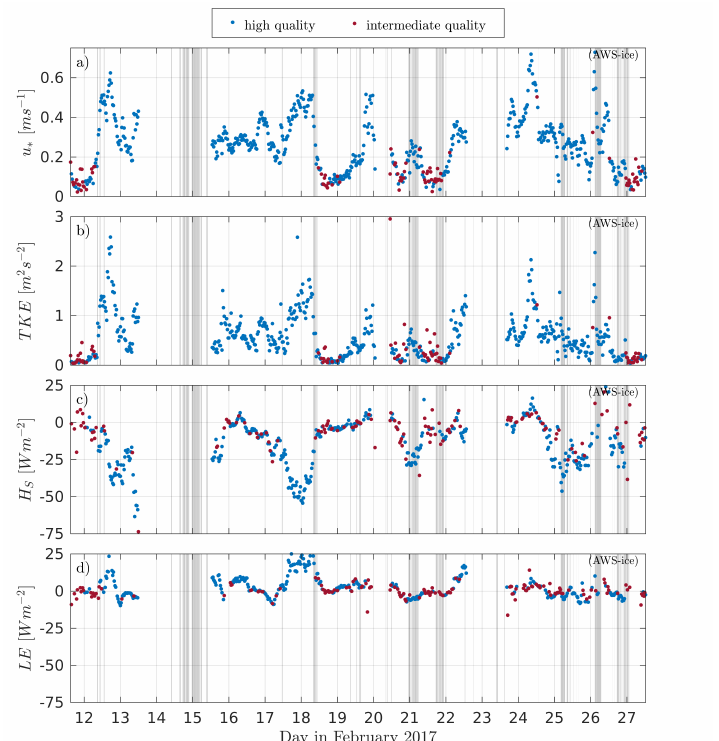
Figure 7. Time series of ( a ) 30-min averaged friction velocity, u ∗ ; ( b ) turbulent kinetic energy per unit mass, TKE ; ( c ) turbulent sensible heat flux, H S ; and ( d ) latent heat flux, LE , observed with the EC system, 2.7m above the sea ice. The quality of the data is indicated by blue and red markers for high and intermediate quality, respectively. Poor quality data is not shown. Gray shading indicates times of UAV